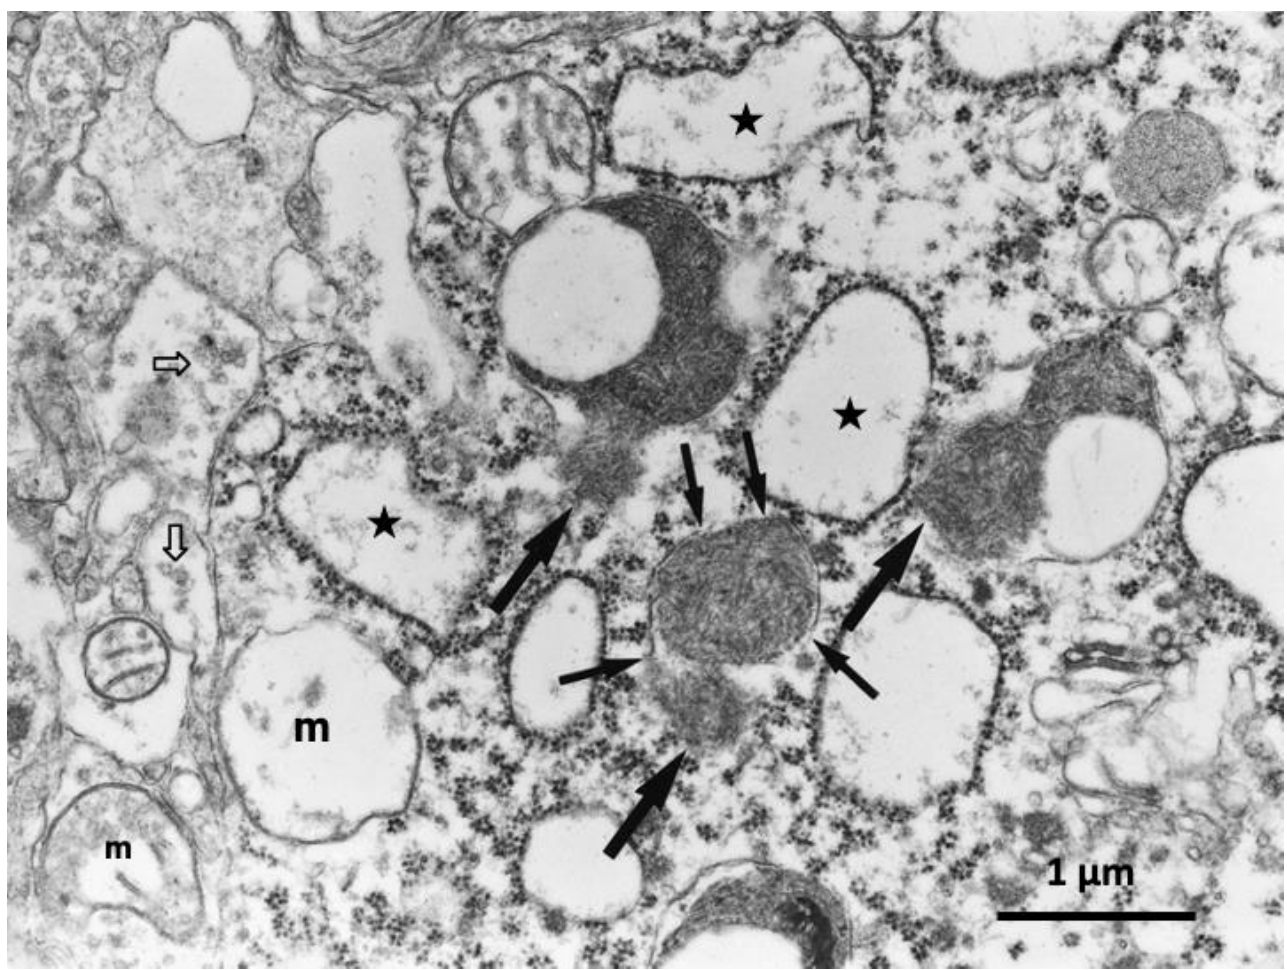
Figure 6. Electron microphotograph of the hippocampal CA1 neuron of a monkey after transient global brain ischemia. Lysosomes show rupture of the limiting membrane (thin arrows) with apparent leakage of the lysosomal content (thick arrows). Both swelling of rough ER (stars) and mitochondria (m) indicate intensity of the acute insult. The synaptic vesicles show a remarkable decrease (open arrows). This is the first electron microphotograph of the lysosomal membrane rupture reported ever (cited from Yamashima et al., Eur. J. Neurosci. 8; 1932–1944, 1996. doi: 10.1111/j.1460-9568.1996.tb01337.x.)